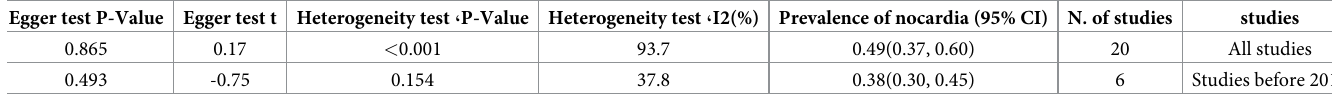
Table 6. Meta-analysis of the prevalence of Nocardia in